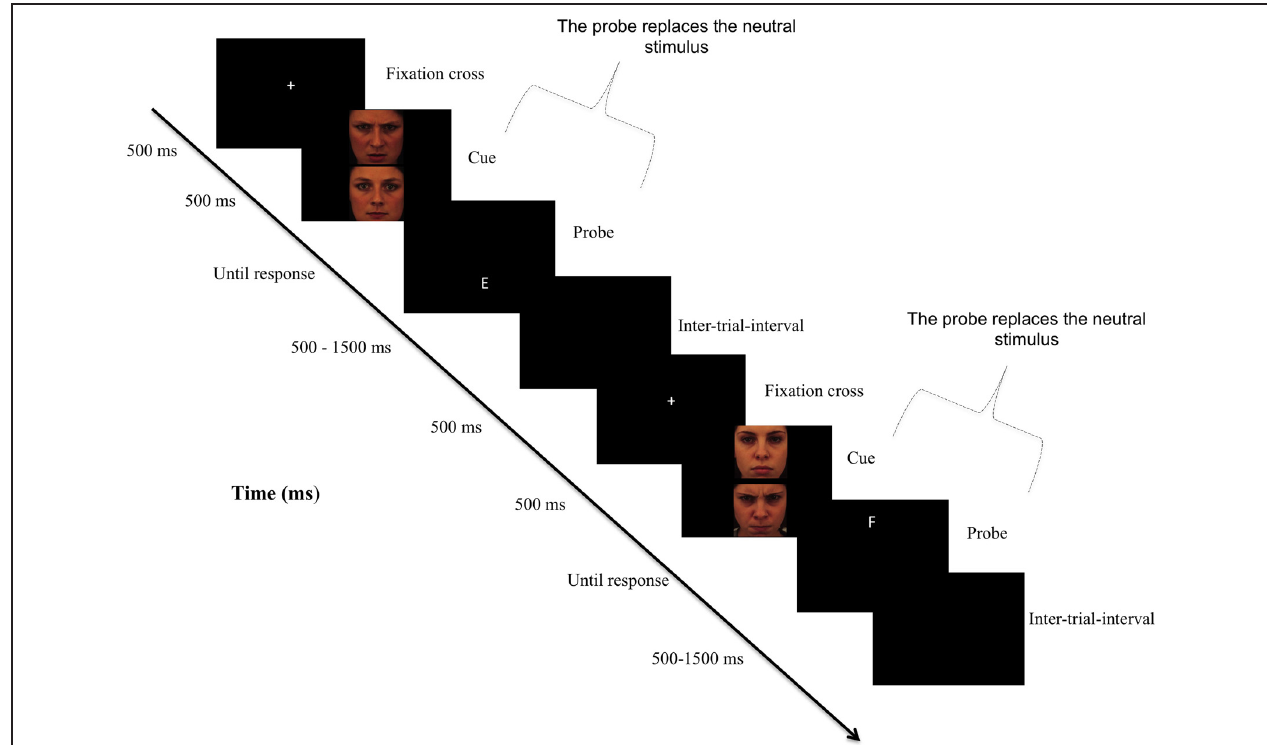
the probe as quickly as possible. In attention training, researchers typically modify the original task such so that the probe nearly always (i.e., 95% of the trials) replaces the neutral stimulus, thereby redirecting subjects’ attention to non-threat cues. In the control condition, there was no contingency between cues and